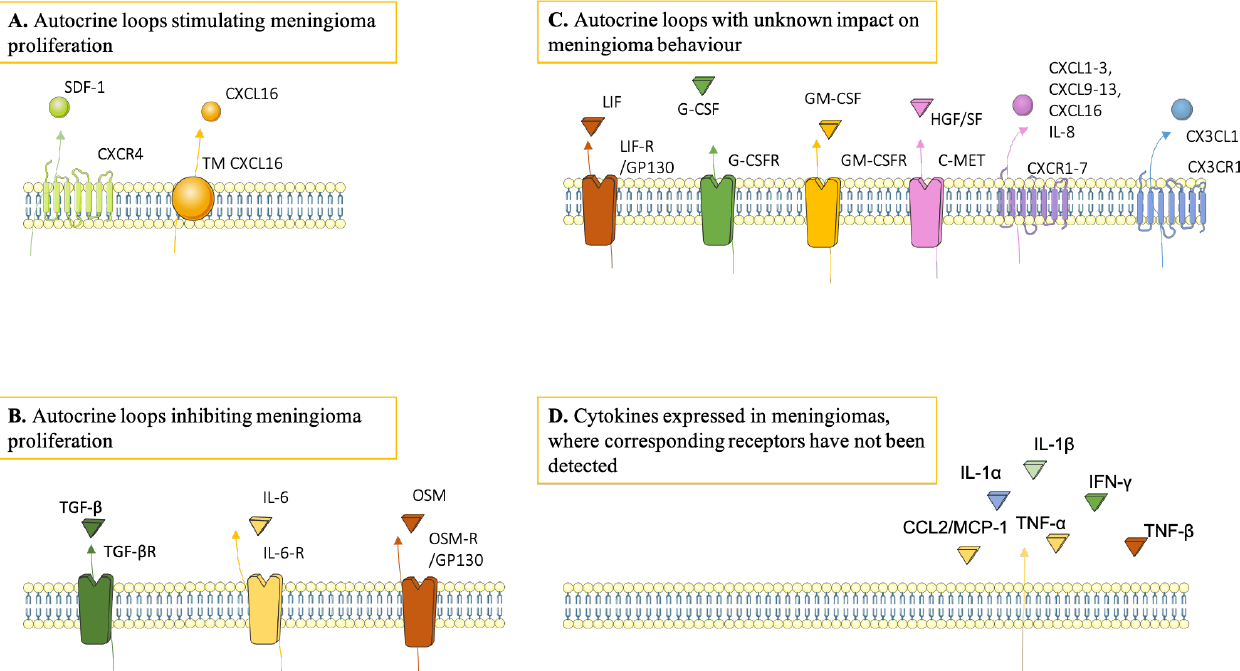
Figure 2. Simultaneous expression of cytokine/cytokine receptor pairs in meningiomas, suggestive of autocrine loops. Some of these autocrine loops showed impact on meningioma growth in vitro. ( A ) SDF-1/CXCR4 and CXCL16/TM-CXCL16 signalling stimulated meningioma proliferation and growth. ( B ) TGF-ß/TGF-ßR, IL-6/IL-6R and OSM/OSM-R signalling inhibited meningioma proliferation and growth ( C ) Loops of which the consequence on meningioma proliferation/growth have not been investigated in vivo. ( D ) Cytokines expressed in meningiomas, where corresponding receptors have not been detected.